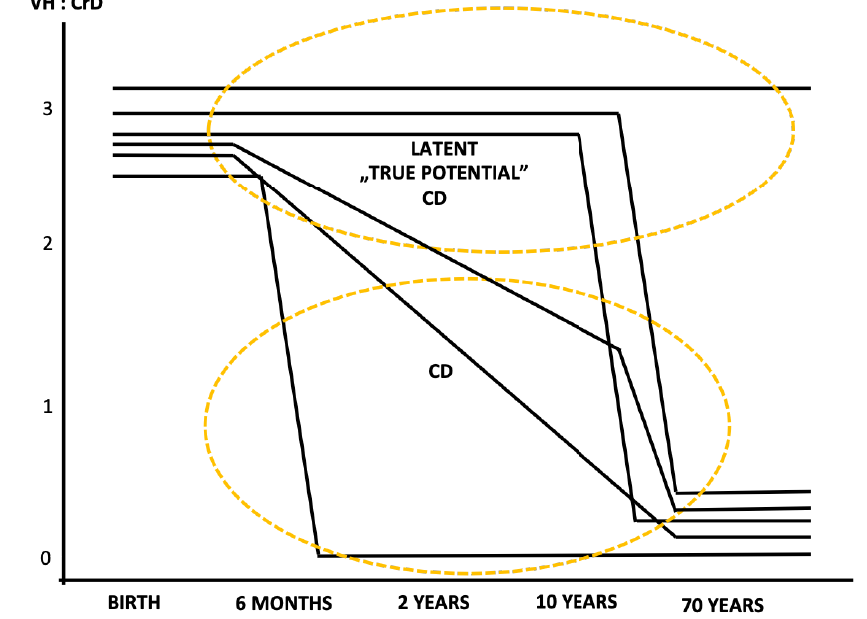
Figure 1. Natural history of developing celiac disease (CD) at the small intestinal mucosal level. Each line represents one individual. We are born with a normal mucosal morphology, a villus height (VH), and a crypt depth (CrD) ratio of approximately three and villi three times taller than crypts are deep. Upon gluten ingestion, mucosal injury proceeds rapidly or gradually at different ages, in childhood or only at an older age. Before developing a manifest mucosal lesion (diseased mucosa on biopsy, VH:CrD <2) every CD patient belongs to the category latent “true potential” CD (normal on biopsy, VH:CrD >2).